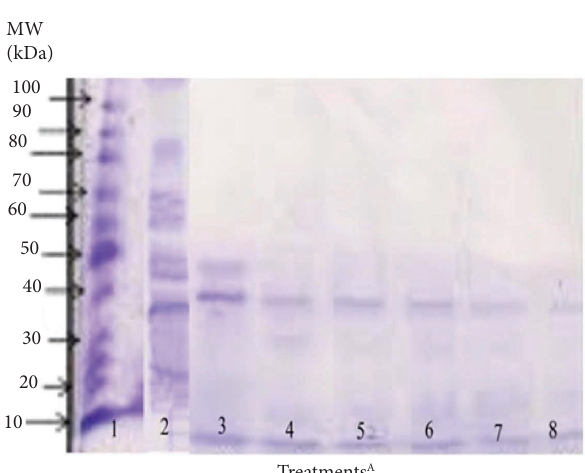
Figure 1: Quinoa protein profle of treatments hydrolysed at diferent conditions analysed by SDS-PAGE. A Treatments de- scriptions are as follows: 1: protein marker, 2: nonhydrolysed protein, 3 (enzyme/substrate ratio (AU/kg protein) and temper- ature ( ° C), respectively): [30, 50]; 4: [30, 55]; 5: [60, 45]; 6: [60, 55]; 7: [90, 40]; 8: [90, 55].